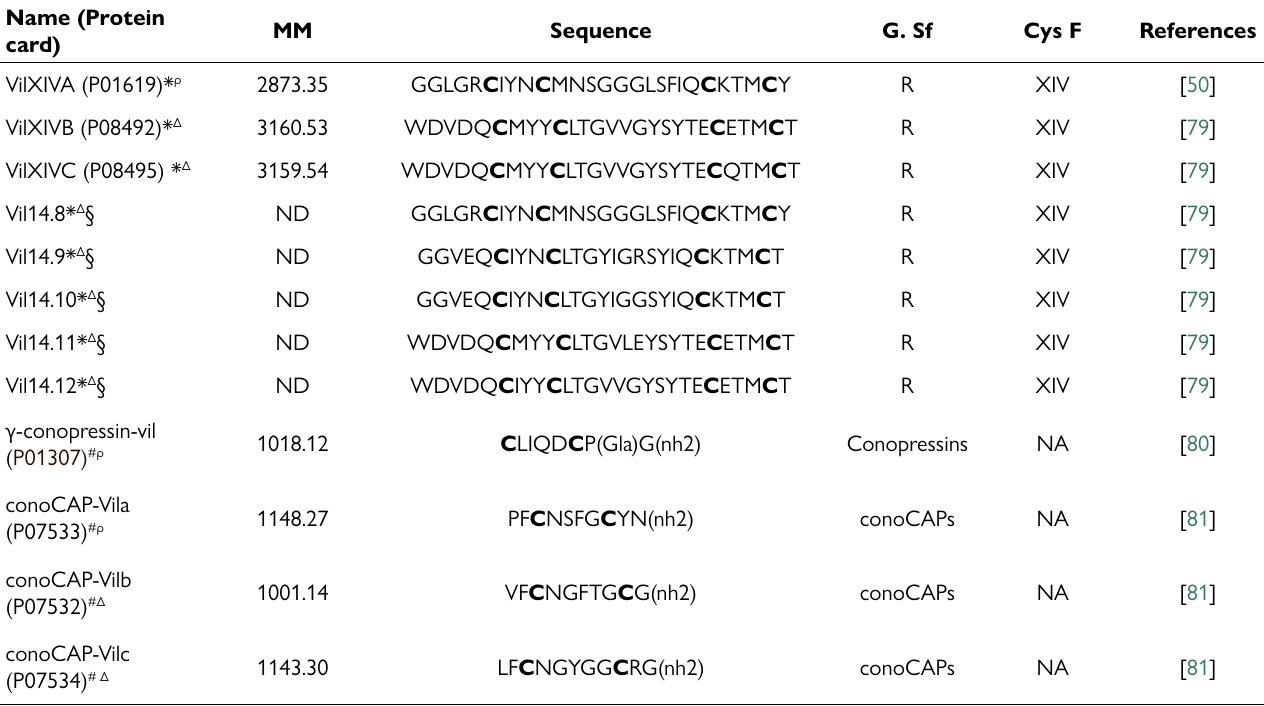
Table 6. Conopeptides identified in the venom of Conus villepinii .